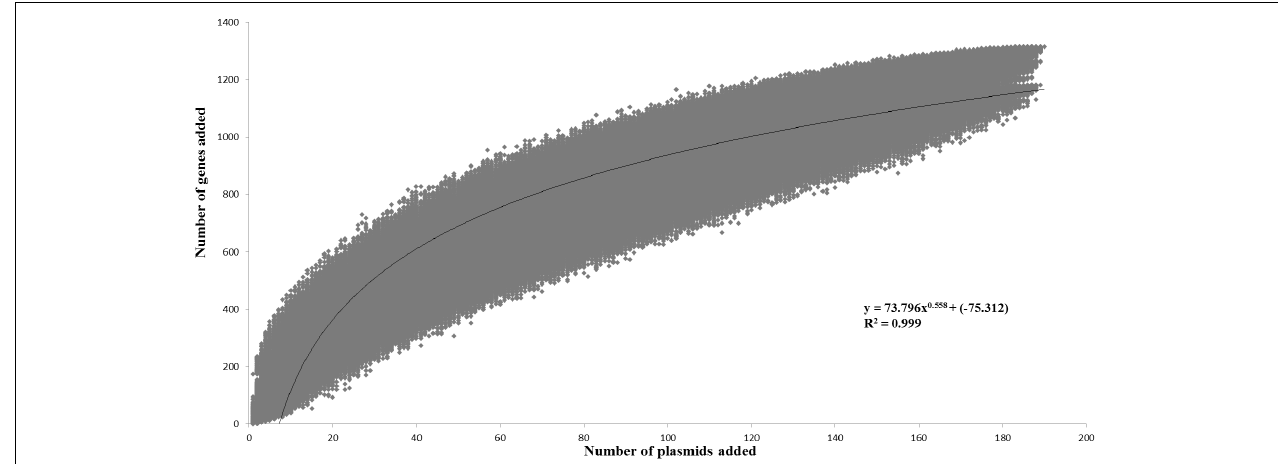
FIGURE 1 | Pan-plasmidome of Lactococcus lactis . This graph represents the accumulated number of new genes in the L. lactis pan-plasmidome plotted against the number of plasmids added. The deduced mathematical equation is also indicated.